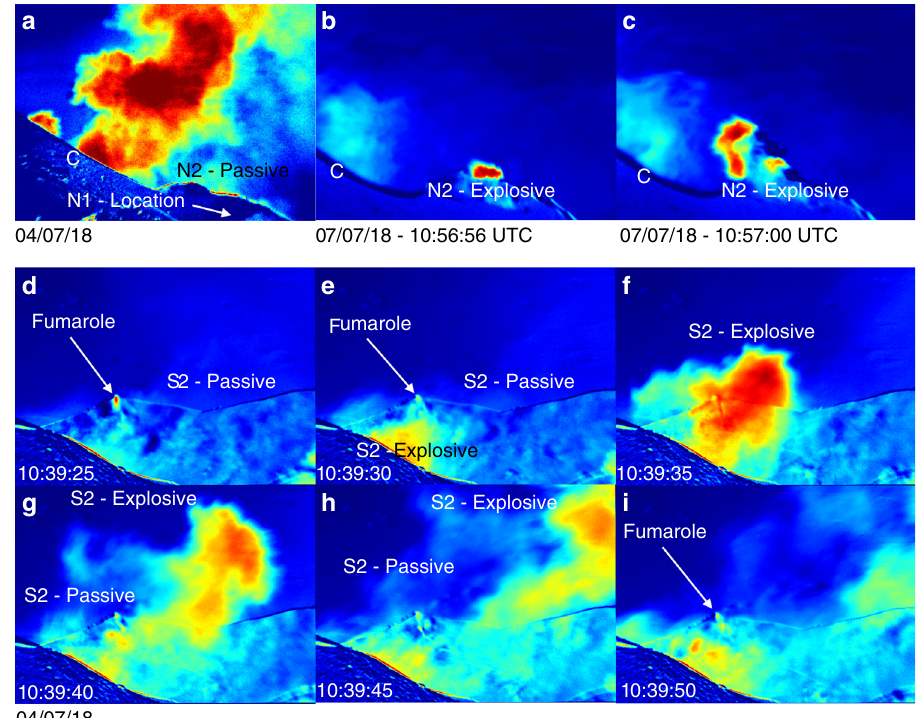
Fig. 2 UV camera absorbance images. Example UV camera absorbance images showing activity from each individual vent imaged. a Data from 04/07/ 18 showing the high contributions of emissions from area C, lack of emissions from N1 and lower contribution to passive degassing from N2; b , c A minor Strombolian explosion from N2 on 07/07/18, as viewed from the north-east; d – i An image sequence showing the evolution of a Strombolian explosion from S2, as viewed from the south.